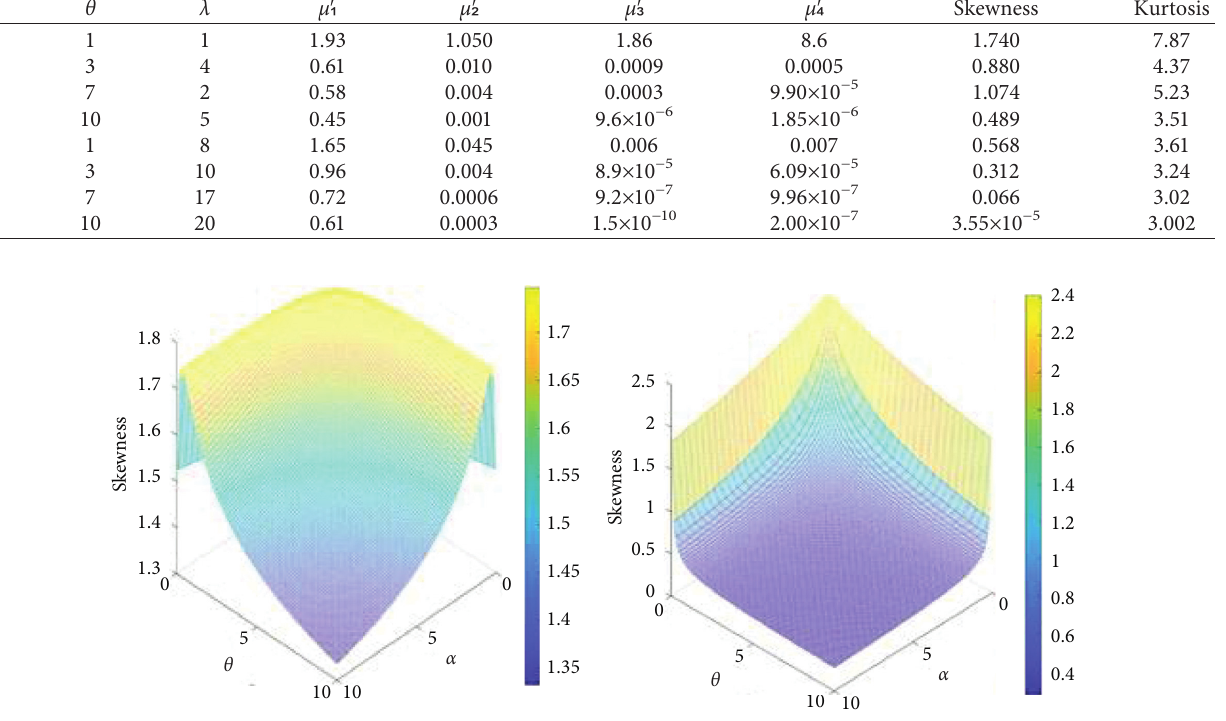
Table 1: Moments, skewness, and kurtosis of the TIITLIFW distribution.